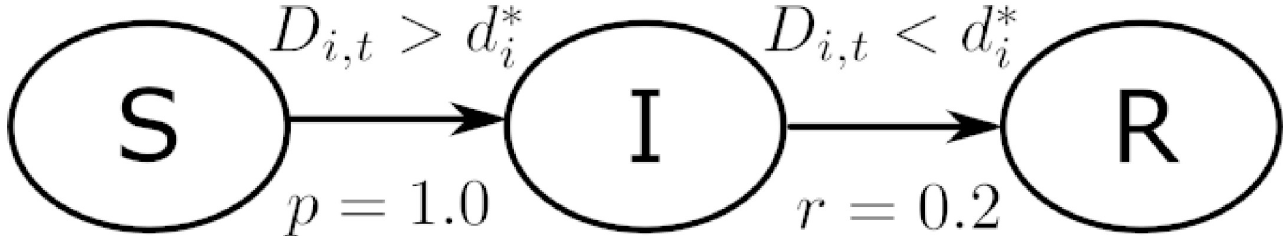
Fig 1. Dosage model state transitions. Each node has three possible states, S , I , and R . Nodes gain doses towards switching states every time they ‘listen’ to another node; doses are nonzero if the ‘speaking’ node is in state I and zero otherwise. When a node in state S has a cumulative dosage over the past T time steps, , it switches to state I . When a node in state I has a cumulative less than its threshold, it has a 20% change per activation to switch D i , t , greater than its threshold, d � i to state R . State R is absorbing.